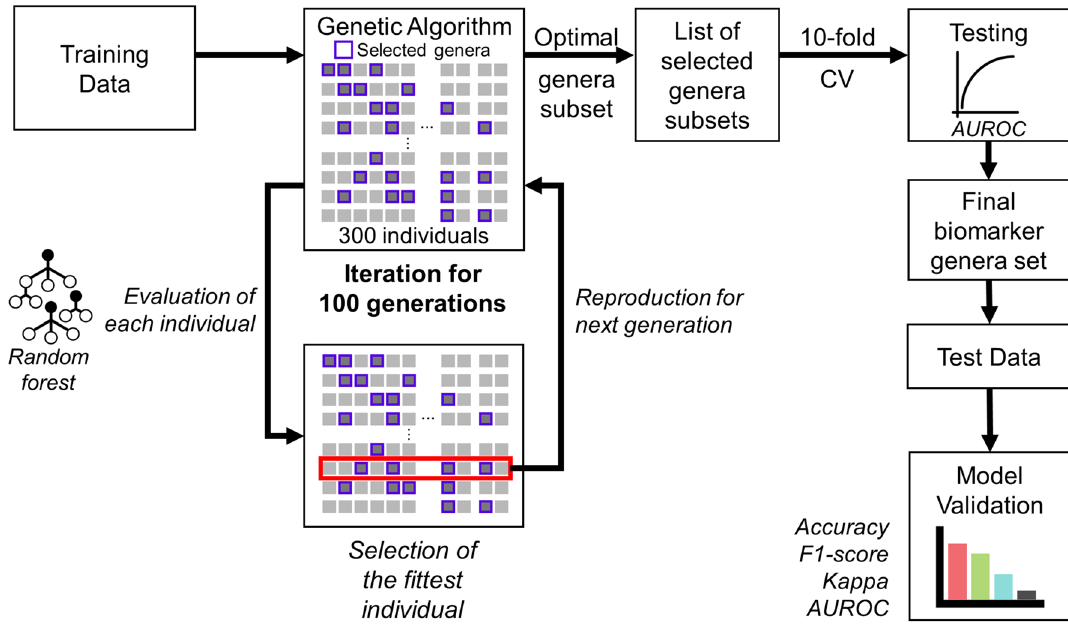
Figure 4. The overview of biomarker genera mining using GA. From the randomly generated initial 300 individuals consisting of genera, the classification model was optimized using GA methods, including crossover and mutation. The model with the highest fitness score is selected for each generation and further sequentially optimized in the next generation. The final model was evaluated using the average AUROC of the tenfold